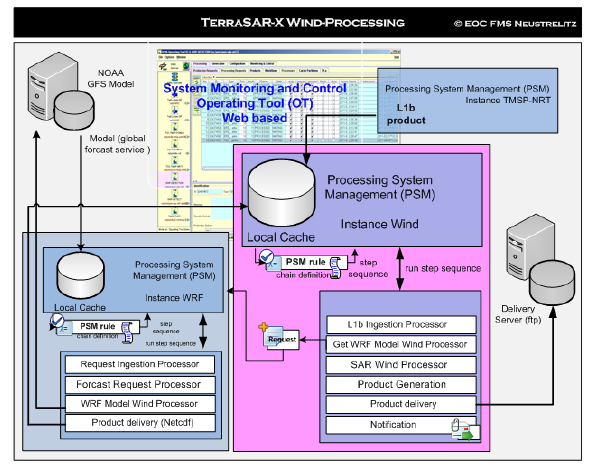
Figure 5. TerraSAR-X NRT wind processing work